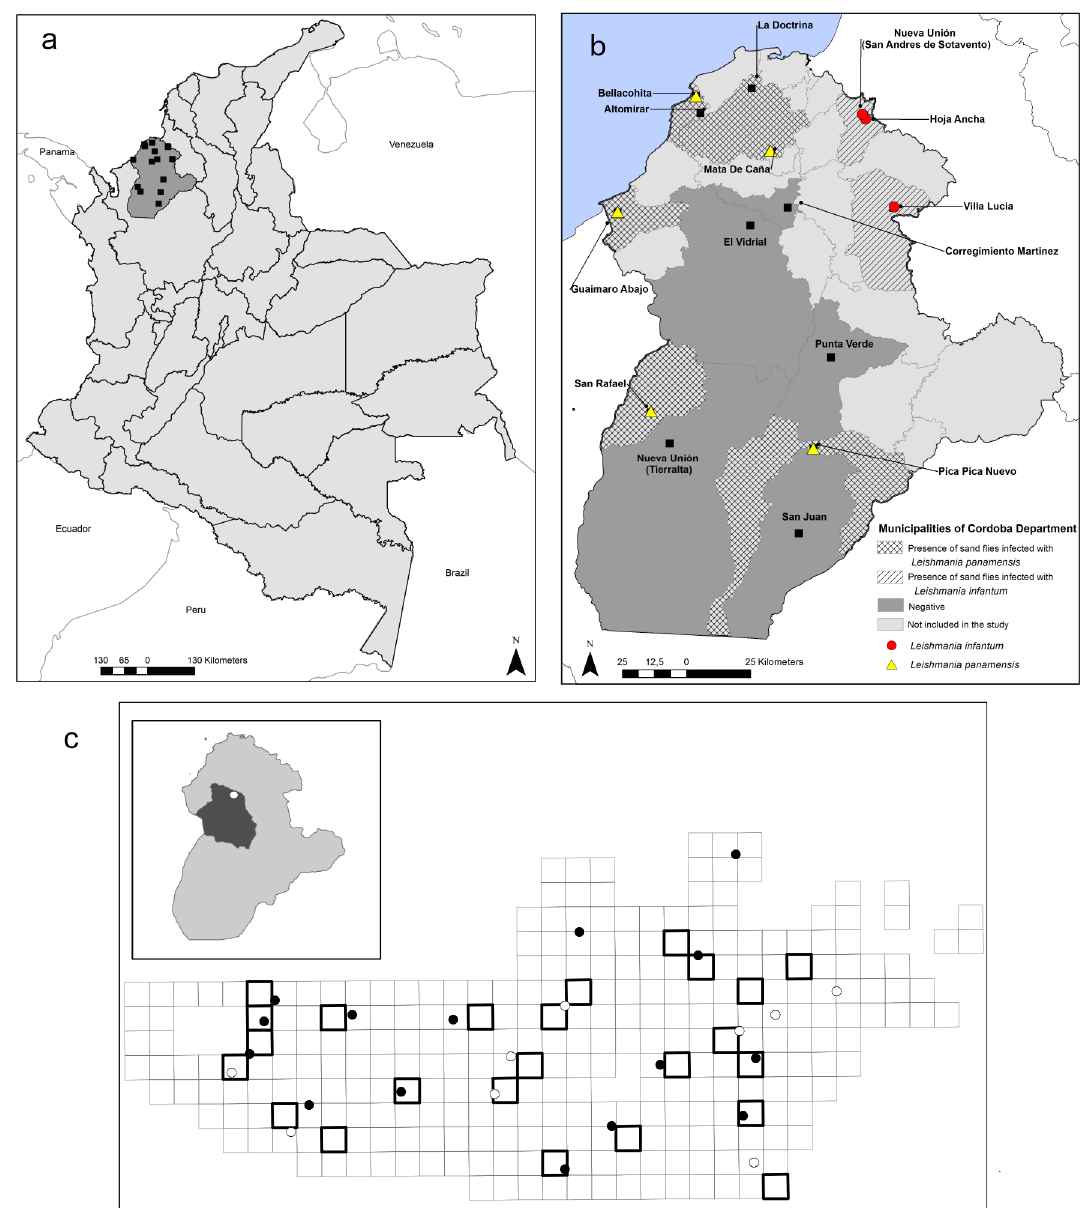
Fig 1. Sampling localities in the Cordoba department in Colombia. a. Co´rdoba department location in the country. b. Fifteen sampled localities in 13 municipalities of the Cordoba department. Colors correspond to the distribution of Leishmania species, in red Leishmania infantum , in yellow L . panamensis and in black localities with no parasites detected. c. Gridded sampling design with a 25m (cid:3) 25m resolution built using satellite images to identify houses. On the grid 24 random cells were selected and the houses present inside were sampled in each locality. This grid is an example that corresponds to the Vereda el Vidrial, Cordoba,